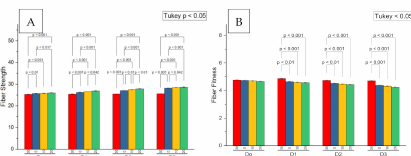
Figure 6. Probability values comparison for the seed dressed (D0 = 0, D1 = 100, D2 = 150 and D3 = 200 mL kg − 1 ) and soil applied potassium humate on the fiber strength ( A ) and the fiber fitness ( B ) of